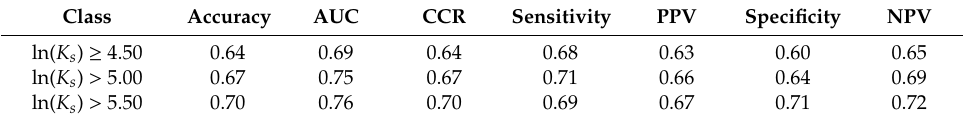
Figure 3. Distribution of ln( K s ) values in the dataset. Thresholds for binary classification models: 4.5 (red), 5.0 (gray), and 5.5 (green). Table 2. Statistical characteristics. The characteristics of the models for 5-fold external